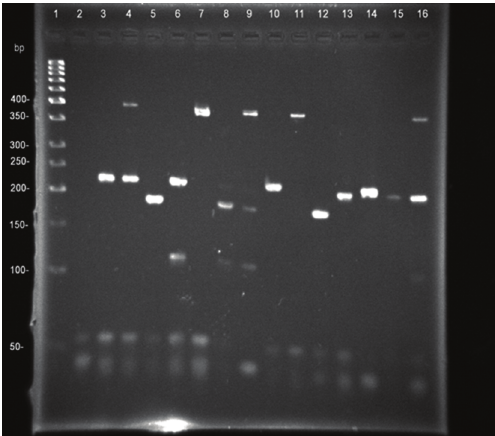
Figure 2: Multiplex PCR using primers ITS1, ITS2, CA3, and CA4. Lane 1: 50-bp DNA ladder. Lane 2: negative control. Lanes 3 to 8, 11 to 13 and 15 to 16: eleven clinical isolates. Lane 9: mixed reference strains C. krusei CBS573, C. albicans ATCC14053, and C. glabrata CBS2175, Lane 10: reference strain C. tropicalis CBS94, and Lane 14: reference strain C . parapsilosis